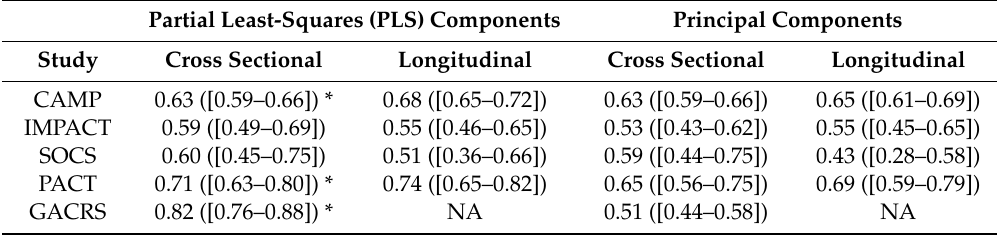
Accuracy of Steroid Responsiveness Endophenotype (SRE) measure assessment by Cross-sectional Asthma STEroid Response Management (CASTER) methodology vs. Steroid Responsiveness Endophenotype (SRE) proxy. Partial Least-Squares (PLS)